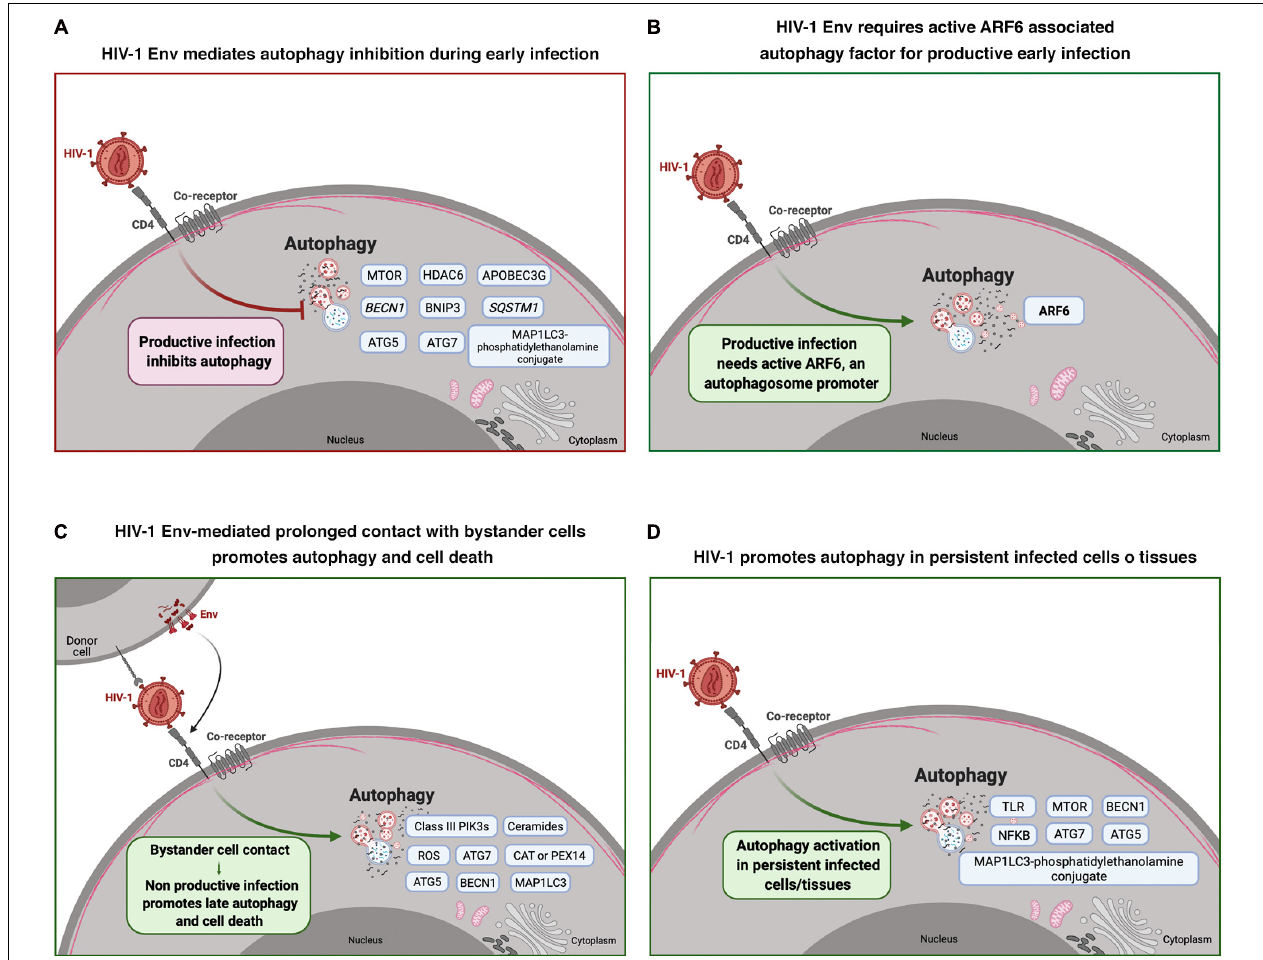
FIGURE 1 | HIV-1 modulation of autophagy during early infection and viral non-productive bystander cell contact, and in persistent infected cells/tissues. Cell scheme summarizing the effect of HIV-1 on autophagy and associated factors in different HIV-1 scenarios. (A) HIV-1 Env mediates autophagy inhibition during early infection in CD4 + T cells. Autophagy associated factors affected by HIV-1 Env signaling are shown in blue boxes. (B) This scheme shows that HIV-1 Env requires active ARF6 associated autophagy factor for productive infection in CD4 + T cells. (C) This panel shows autophagy associated factors (blue boxes) that are activated during non-productive virus-bystander cell contacts. This HIV-1 Env-triggered late autophagy activation leads to CD4 + cell death. (D) This panel shows autophagy associated factors (in blue boxes) that are activated by HIV-1 infection in persistent infected cells and/or tissues. Arrow colors represent the reported positive (green) and negative (red) effects on the different steps of the viral life cycle, with dotted arrows signaling the HIV-1 activation pathway. This figure supports the information summarized in Table 1 . Cell schemes were created with